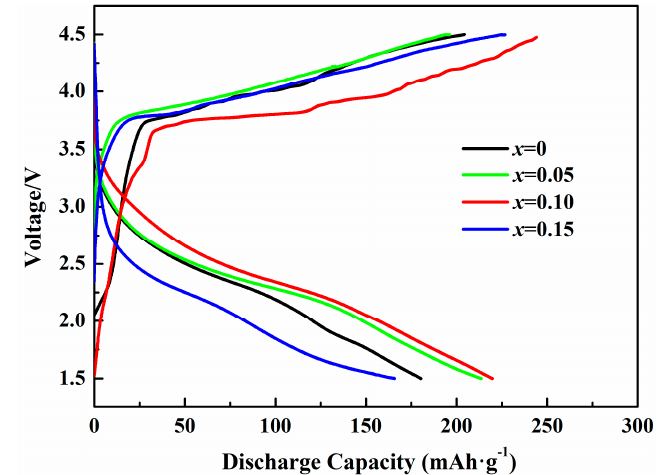
Figure 6. The initial charge–discharge profiles of the synthesized Li 2 Mo 1 − x Co x O 3 ( x = 0, 0.05, 0.10, 0.15) between 1.5 and 4.5 V at 5 mA · g − 1 .